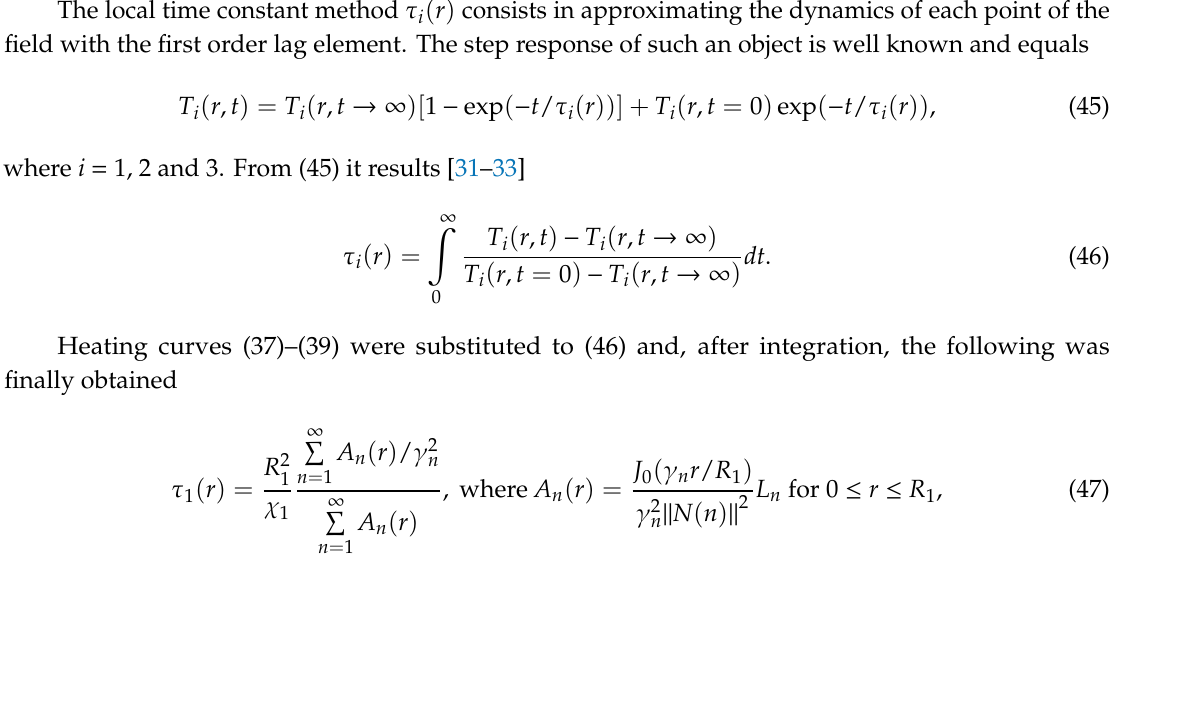
Figure 4. Relative difference (44) of temperature increases determined by means of the Green’s and finite element methods for ( α M , ρ M ) parameters.